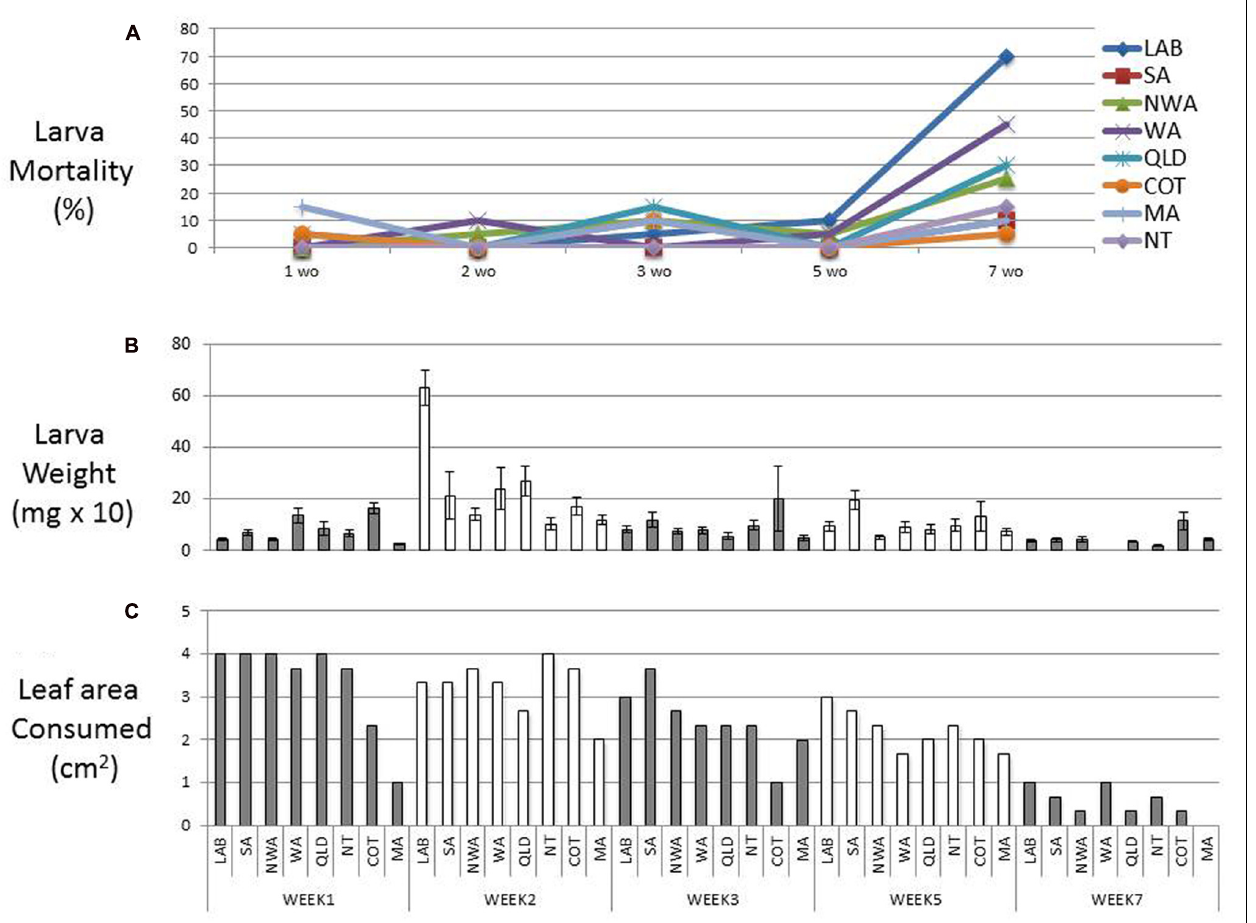
FIGURE 1 | Feeding bioassay. Mortality (A) and average weight (B) of first instar Helicoverpa armigera after 4 days of feeding on 1, 2, 3, 5, and 7 weeks old plants. All data are means ± SD ( n = 30). The leaf area consumed for each feeding treatment is represented in (C) . Six different accessions of Nicotiana benthamiana [one LAB strain and five wild strains (SA, NWA, WA, QLD, NT; (Bally et al., 2015), cotton (COT) and maize (MA), were also